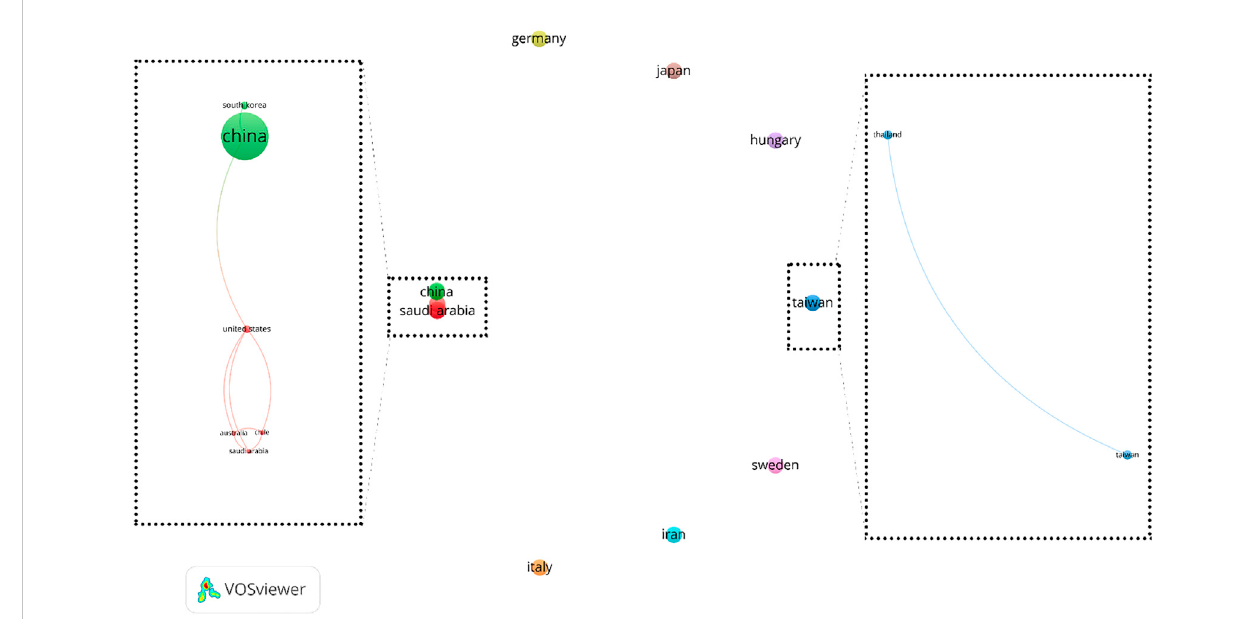
FIGURE 5 Country co-authorship networks (criteria: countries with at least 1 article in the fi eld of exosome and OEC).